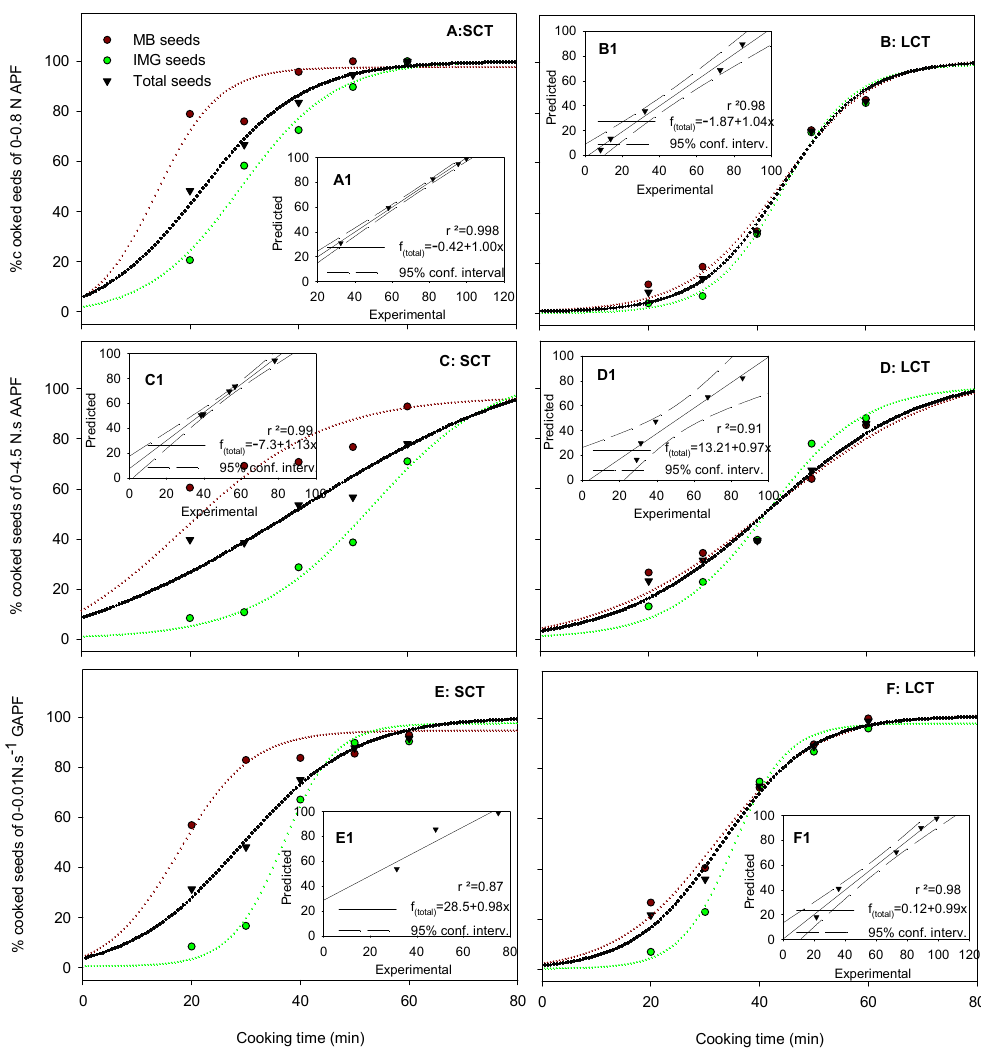
Figure 4. The evolution of the percentage of cooked seeds based on APF (absolute positive force, ( A , B )), AAPF (area to absolute positive force, ( C , D )), and GAPF (gradient to absolute positive force, ( E , F )) values of MB, IMG, and total lentil seed samples, of either easy (SCT) or hard (LCT) to cook lentil seeds, during cooking at 100 ◦ C for 20–60 min. Dashed lines represent curve fitting according to the sigmoid model. The enclosed figure within each graph shows the correlation of experimental versus predicted values of the total seed